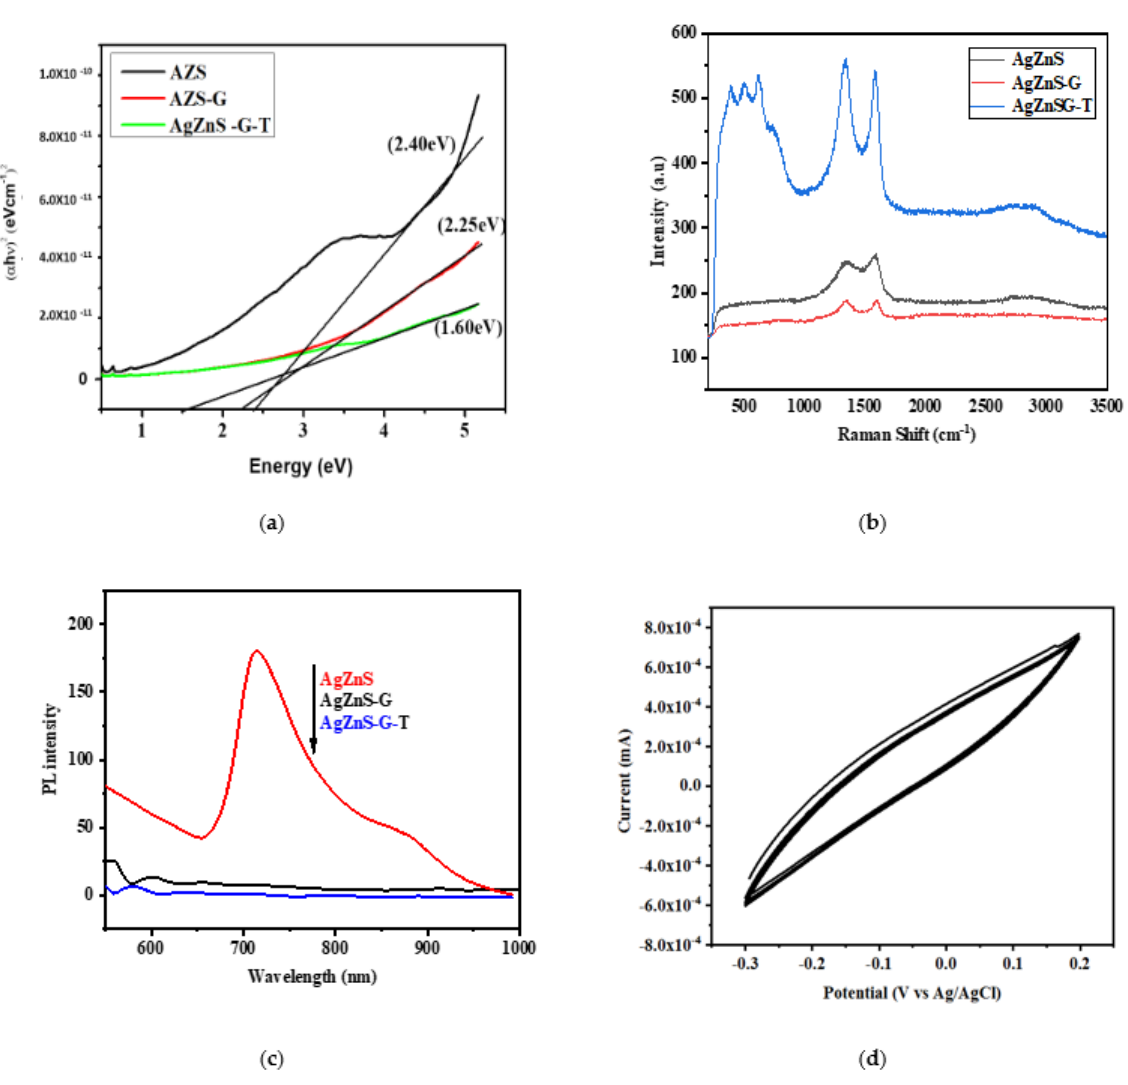
Figure 4. ( a ) UV-Vis DRS spectra; ( b ) RAMAN spectra; ( c ) PL spectra of AgZnS, AgZnS-G, and AgZnS-G-T photocatalysts; ( d ) cyclic voltammetry of AgZnS-G-T photocatalysts.